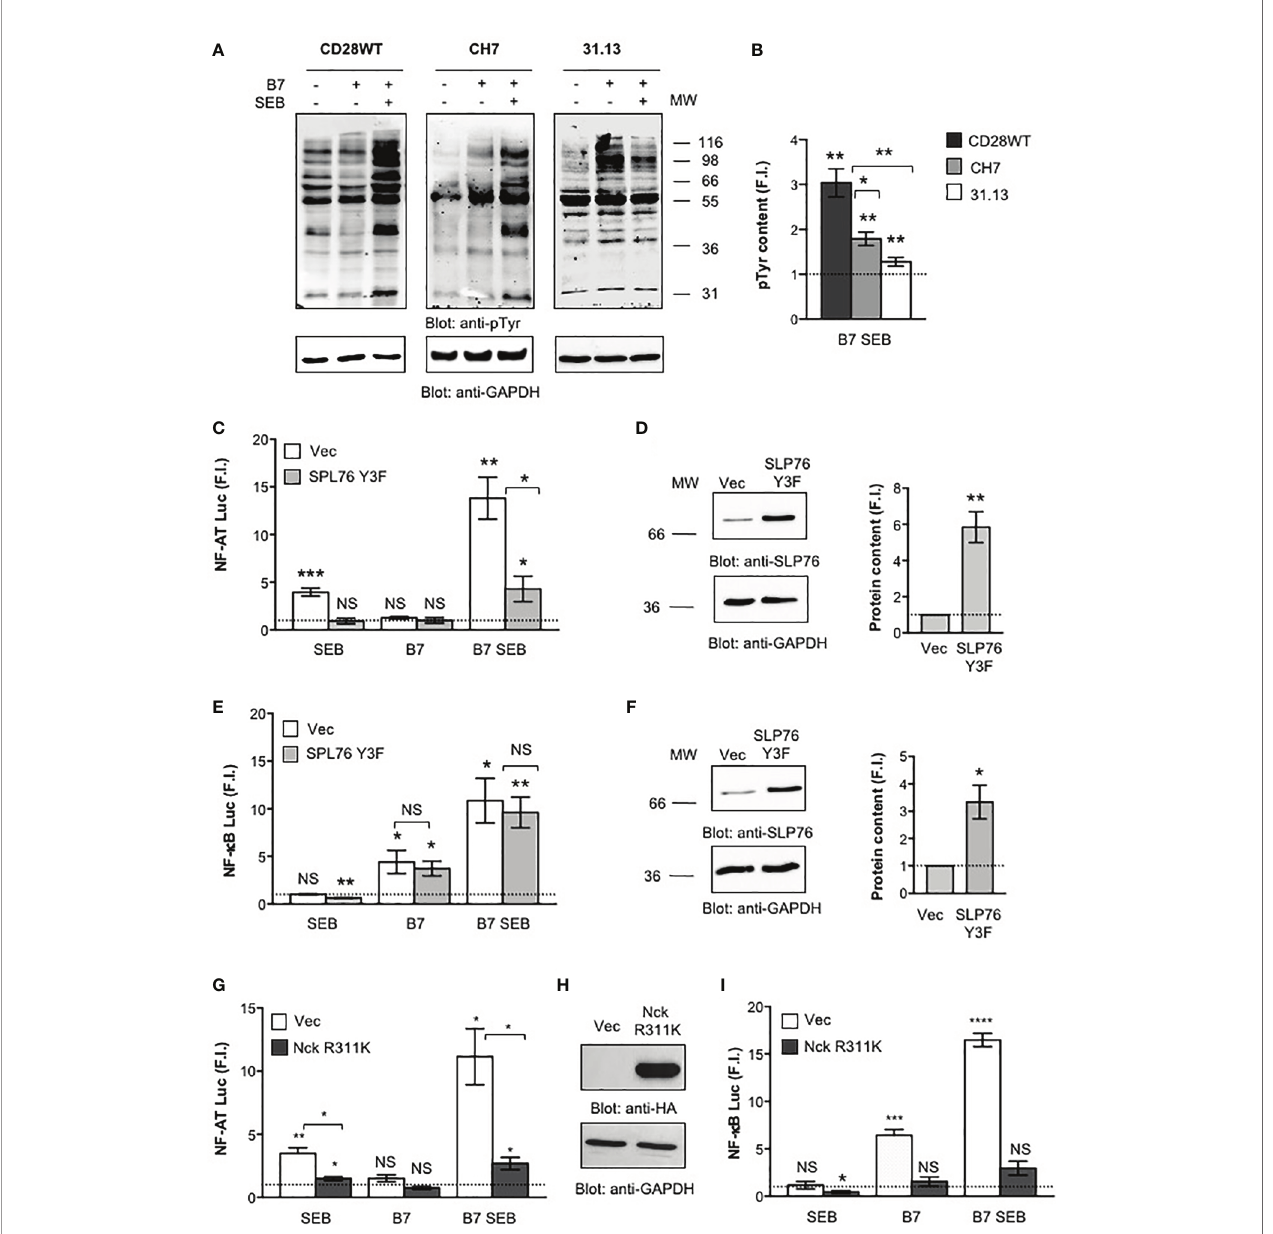
FIGURE 6 | Phosphotyrosine and signalling mediators activated by both TCR and CD28 are required for SEB in fl ammatory activity. (A, B) CD28WT, CH7 and 31.13 cells were unstimulated or stimulated for 2 minutes with SEB in the presence or absence of Dap3/B7 cells (B7). Phosphotyrosine (pTyr) (upper panel) and GAPDH (lower) levels were analysed by western blotting (A) and quanti fi ed by densitometric analysis. pTyr content, normalized to GAPDH, was expressed as fold induction (F.I.) over the basal level of unstimulated cells (B) . The position of molecular weight (MW), expressed in kDa, is indicated on the right. Bars represent mean ± SEM of three independent experiments. Statistical signi fi cance was calculated by Student ’ s t test. (C – I) NF-AT (C, G) and NF- k B (E, I) luciferase activities of CD28WT cells transfected with empty vector (Vec) or Flag-SLP-76 Y3F mutant (C – F) or HA-Nck R311K (G – I) and activated for 6 hours with SEB in the presence or absence of Dap3/B7 (B7). The results were expressed as fold induction (F.I.) over the basal level of unstimulated cells transfected with Vec after normalization of GFP expression. Data show the mean ± SEM and statistical signi fi cance was calculated by Student ’ s t test. Anti-SLP-76 (D, F) , anti-HA (H) and anti- GAPDH western blotting was performed on total lysates. The position of molecular weight (MW), expressed in kDa, is indicated on the left. SLP-76 content (D, E) , normalized to GAPDH, was expressed as fold inductions (F.I.) over the basal level of unstimulated cells. Bars represent mean ± SEM and statistical signi fi cance was calculated by Student t test. Luciferase mean values: (C, E) NF-AT (n = 4), Vec SEB = 3.9, SLP-76 Y3F SEB = 0.9, Vec B7 = 1.2, SLP-76 Y3F B7 = 1, Vec B7 SEB = 13.8, SLP- 76 Y3F = 4.3; NF- k B (n = 3), Vec SEB = 1.0, SLP-76 Y3F SEB = 0.6, Vec B7 = 4.4, SLP-76 Y3F B7 = 3.7, Vec B7 SEB = 10.8, SLP-76 Y3F = 9.6; (G, I) NF-AT (n = 3), Vec SEB = 3.4, Nck R311K SEB = 1.4, Vec B7 = 1.5, Nck R311K B7 = 0.7, Vec B7 SEB = 11.1, Nck R311K B7 SEB = 2.6; NF- k B (n = 3), Vec SEB = 31.1, Nck R311K SEB = 0.4, Vec B7 = 6.4, Nck R311K B7 = 1.5, Vec B7 SEB = 16.4, Nck R311K B7 SEB = 2.9. (*) p < 0.05, (**) p < 0.01, (***) p < 0.001, (****) p < 0.0001, NS, not signi fi